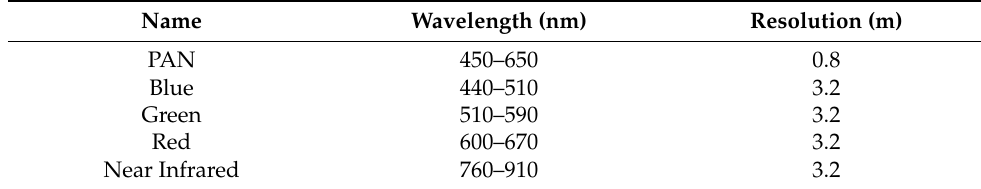
Table 2. Detailed information of the five spectral bands from the BJ-2